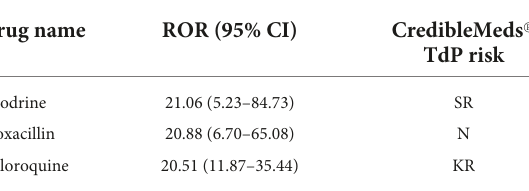
TABLE 3 Reported odds ratios for the top 50